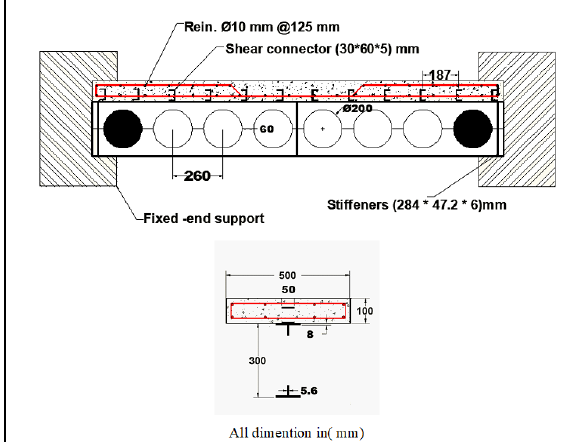
Figure 1: Cellular beam details